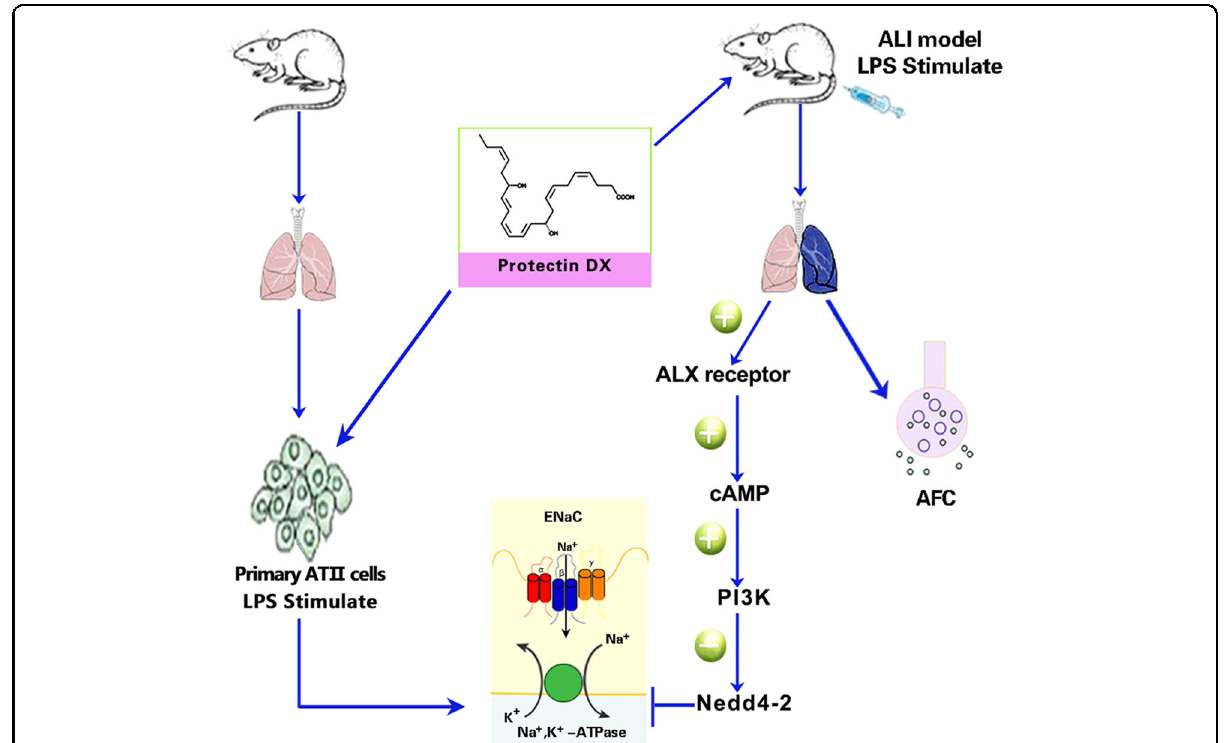
Fig. 7 Protectin DX protected against LPS-induced acute lung injury in vivo and in